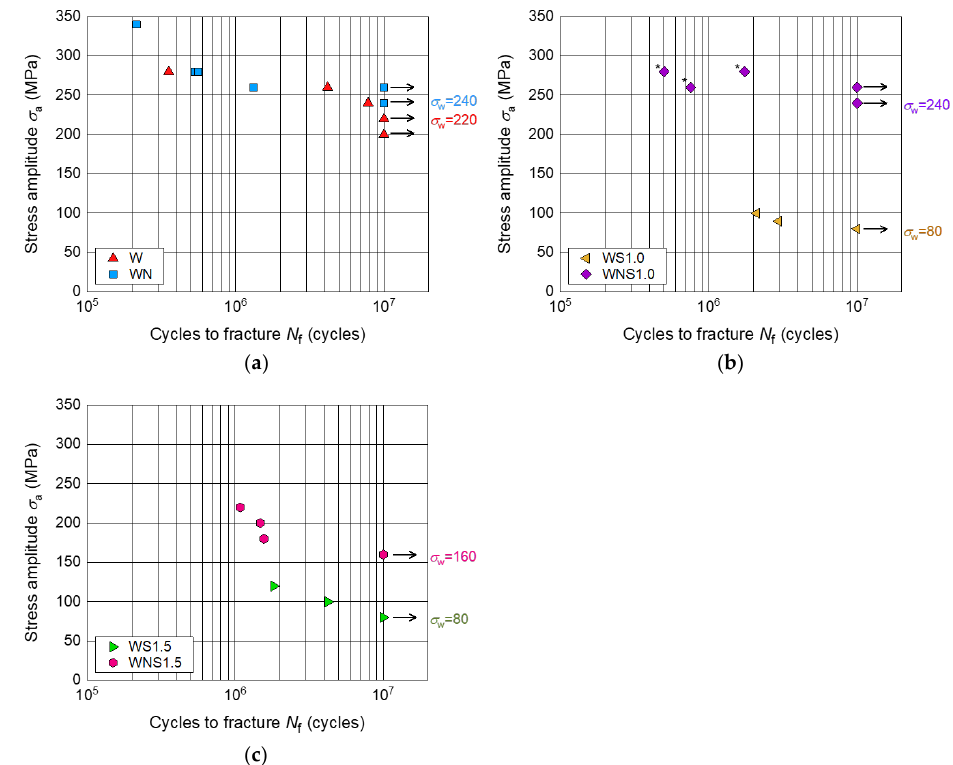
Figure 5. S - N diagram of ( a ) W and WN, ( b ) WS1.0 and WNS1.0 and ( c ) WS1.5 and WNS 1.5. The S - N diagram plots nominal stress amplitude ( σ a ) against cycles to fracture ( N f ). Three-point bending fatigue tests were performed with load control. The span length of the three-point bending was 80 mm. All tests were performed at a stress of R = 0.05 and a frequency of f = 20 Hz. The fatigue test was terminated after 1 × 10 7 cycles. The asterisks (*) indicate that a fatigue crack occurred at a different location compared to the slit. Fatigue limits σ w for each type of the specimen were indicated outside the frame of the graph.